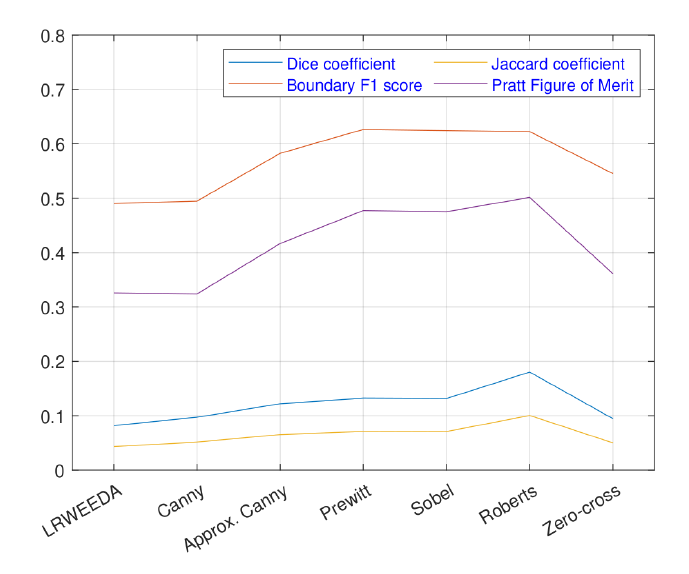
Figure 13. Comparison of the performance